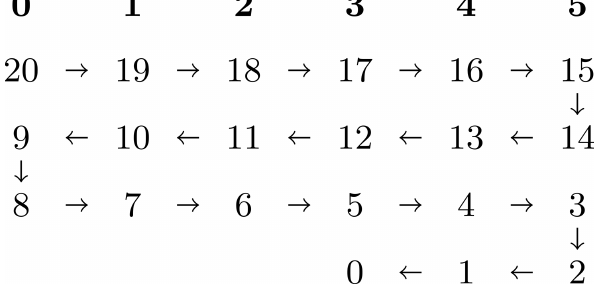
Figure 1. Illustration of the “snake ordering” of the ((cid:96),m) tuples for the 1d-hybrid distribution with N (cid:96) = 21 and (cid:53) r = 6. The top row shows the processor number in boldface, and the remaining num- bers indicate the (cid:96) modes; (cid:96) + 1 solution steps are associated with each (cid:96) value. The arrows illustrate the snake-like winding pattern of this